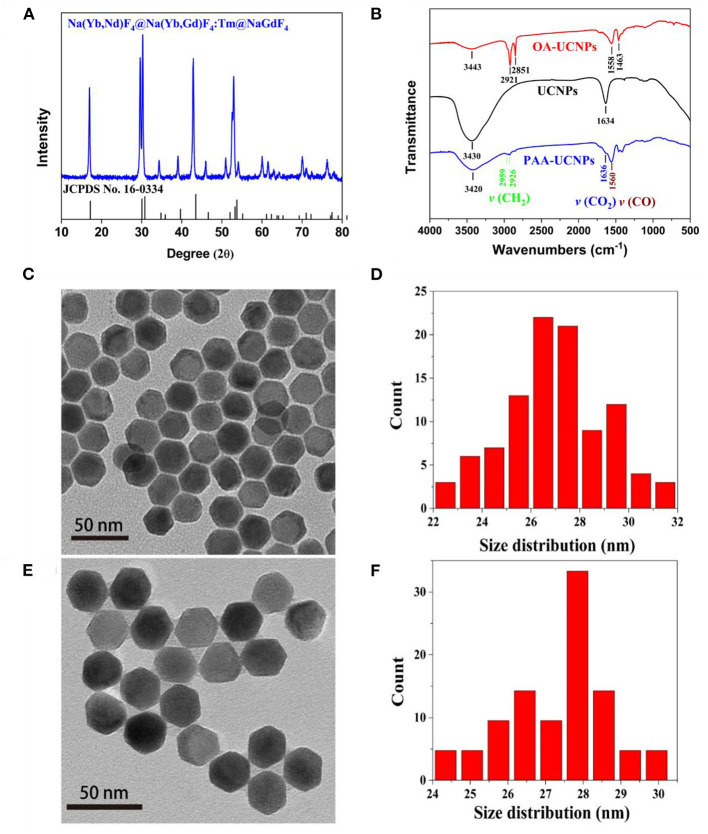
(A) XRD pattern of OA-capped NaYb0.5Nd0.5F4@NaYb0.5Gd0.49Tm0.01F4@NaGdF4 UCNPs in comparison with standard JCPDS No. 16-0334, (B) FT-IR spectra of the OA-capped, un-capped, and PAA-capped NaYb0.5Nd0.5F4@NaYb0.5Gd0.49Tm0.01F4@NaGdF4 UCNPs, and (C,E) TEM images; and (D,F) size distribution of the as-prepared OA-capped and PAA-capped NaYb0.5Nd0.5F4@ NaYb0.5Gd0.49Tm0.01F4@NaGdF4 UCNPs, respectively.